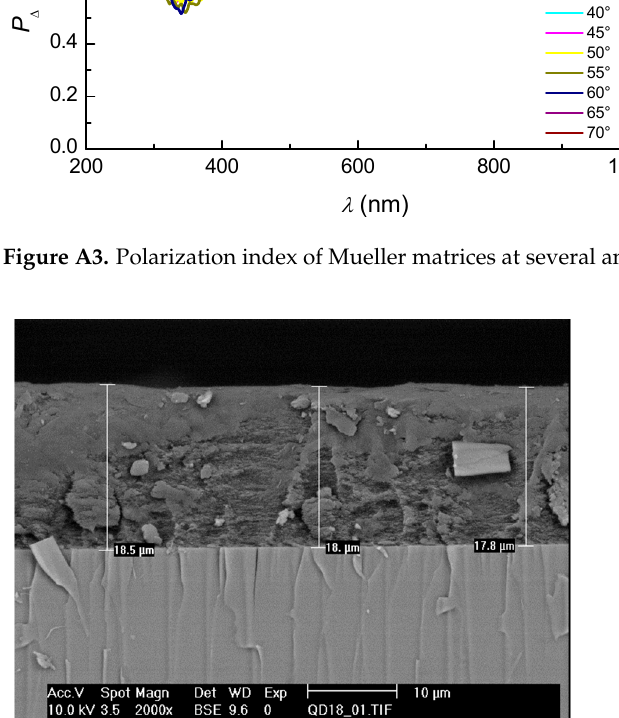
Figure A4. Cross ‐ sectional scanning electron microscopy image of the film.